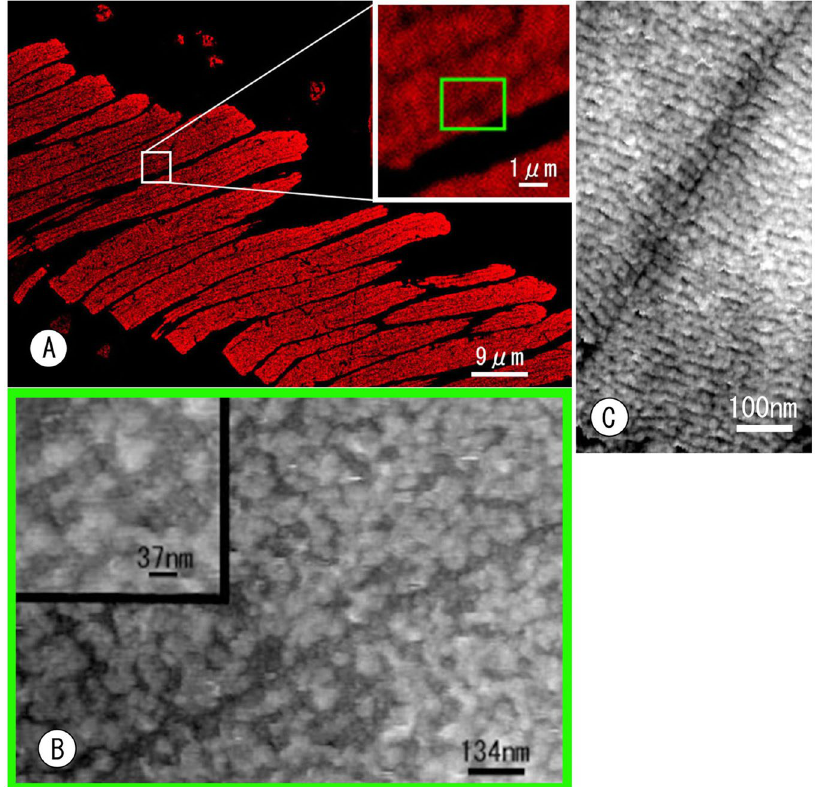
Figure 5. AFM immunocytochemistry identifying anti-opsin antibody binding ( A , B ). The anti-opsin antibody was used to evaluate whether AFM visualized the antibody binding because opsin is the major constituent protein that localizes to ROS. A: Immunofluorescence images of ROS labelled with the anti-opsin antibody and the secondary antibody conjugated to Alexa 568. The inset shows an enlargement of the white box. ( B ) Correlative AFM images of the green boxed area in A. Compared with the control ( C ), the anti-opsin antibodies conjugated with the secondary antibodies appear to have a complicated shape and bind heavily to disks in the ROS. The disk arrangement is also apparent behind the labelling at higher magnifications (inset). ( C ) Control AFM image incubated with non-immune